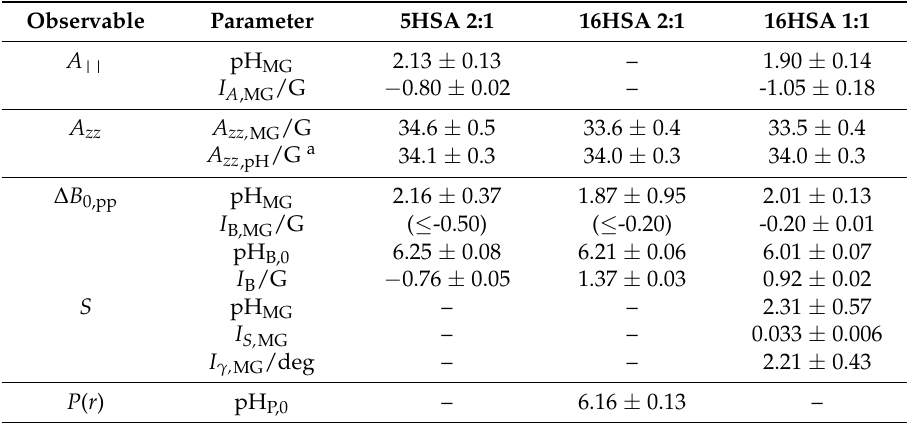
Table 3. Characteristics observed from 5 ‐ and 16 ‐ DSA ‐ probed HSA.